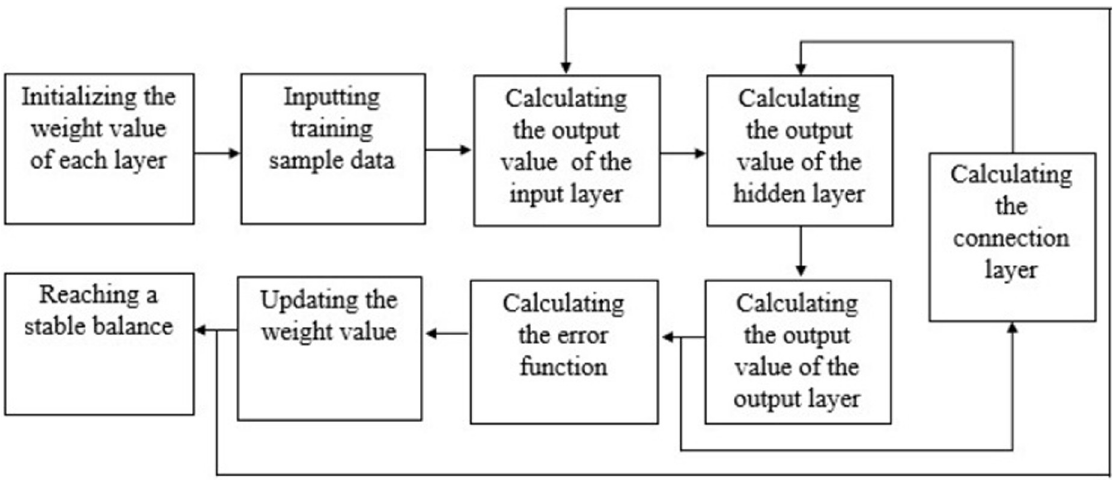
Fig 2. Operation logic of Elman neural